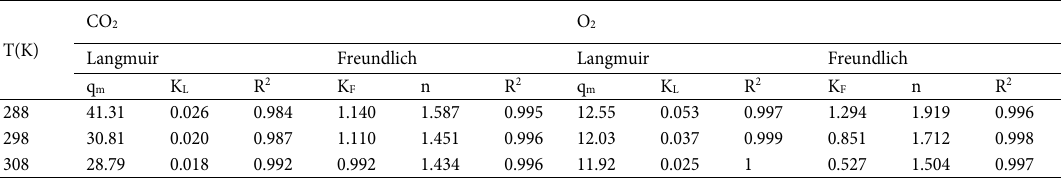
/ to O adsorbed on MWCNT at 2 2 2 different temperature and different pressure for 50:50 gas-phase. and O on 2 2